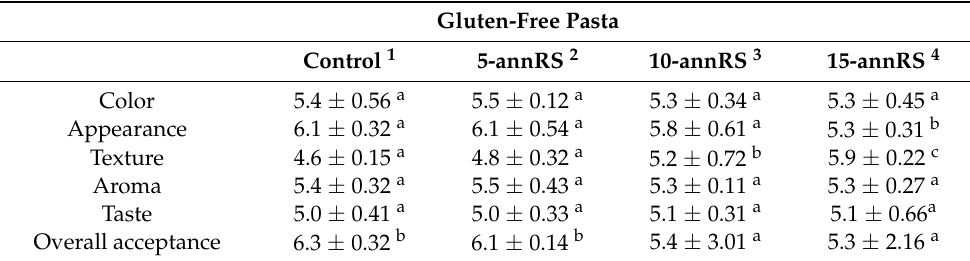
Table 4. Average sensory scores of gluten-free macaroni containing resistant starch from annealed white sorghum starch